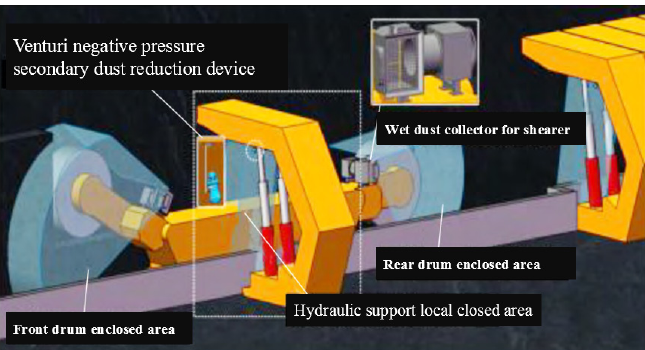
Figure 9. Principle sketch of partially closed atomization dust removal in shearer–hydraulic support area [63,64].